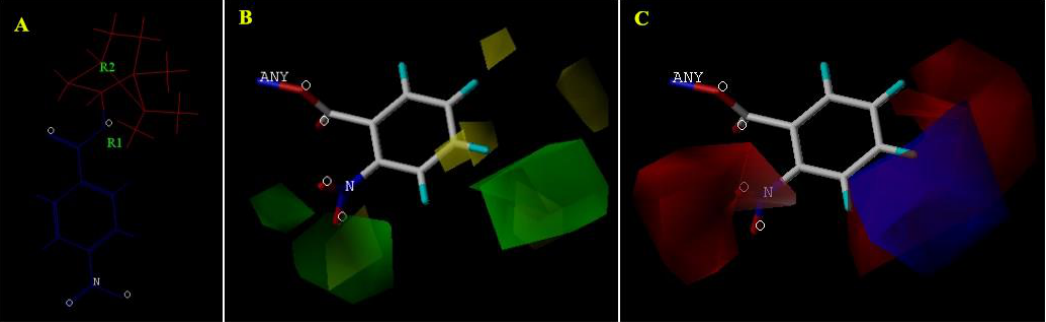
Figure 3. ( A ) Topomer comparative molecular field analysis (CoMFA) contour maps of 3j ; ( B ) The steric field around R1 of 3j ; ( C ) The electrostatic field around R1 of 3j .